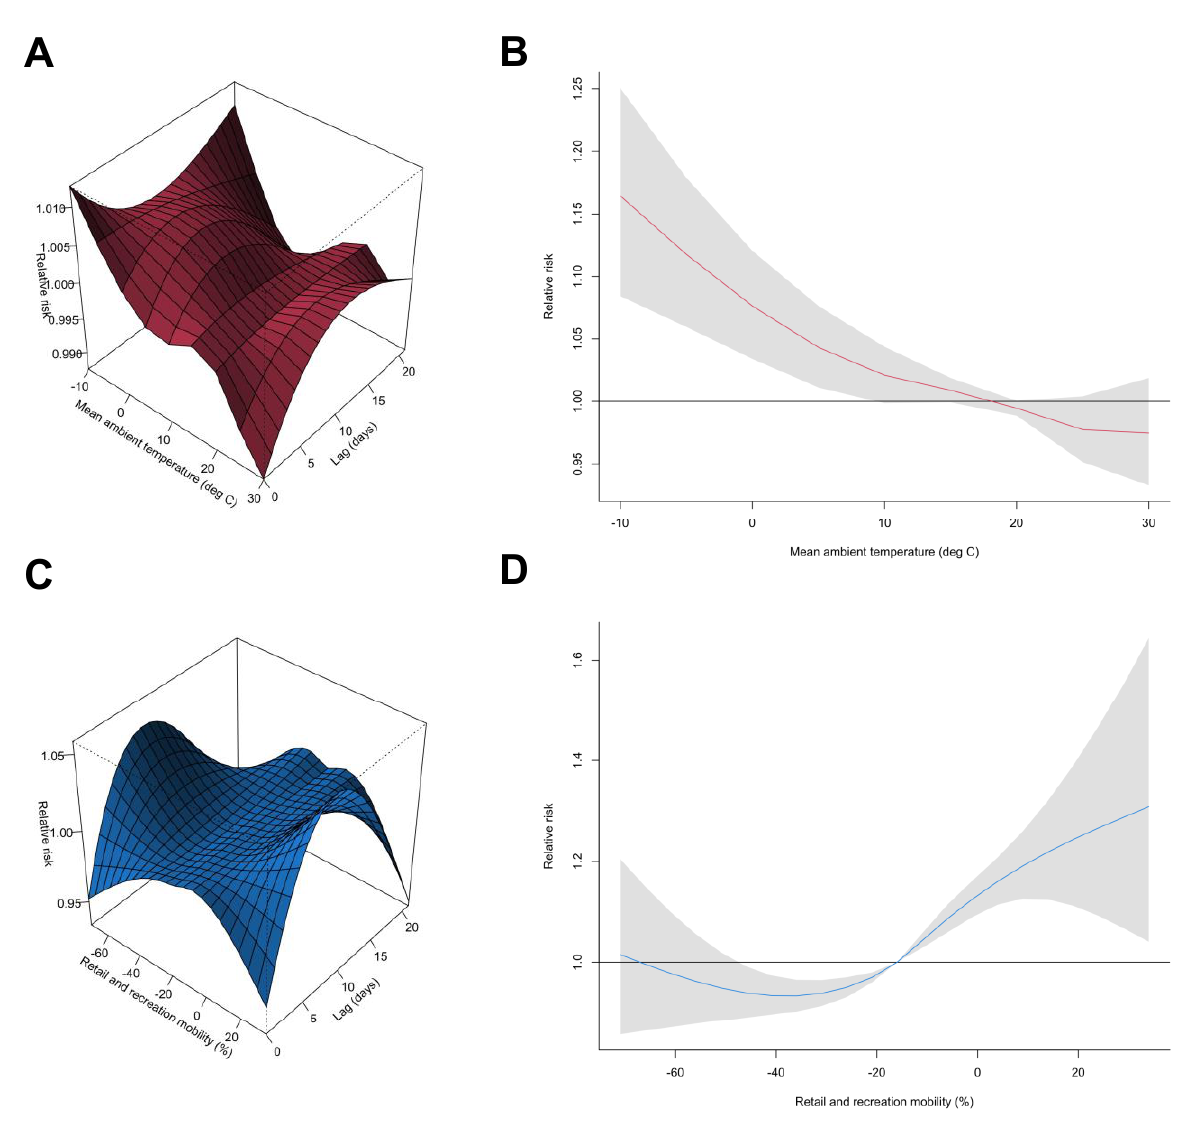
Figure 3. Visualizing pooled non-linear and delayed associations of the relative risks of time-dependent SARS-CoV-2 transmissibility with mean ambient temperature and retail and recreation mobility. ( A ) Three-dimensional plot of the association between daily mean ambient temperature (units: ◦ C) and the percent change in estimated time-dependent effective reproductive number ( R t ) over a lag of 21 days. ( B ) Overall associations of the 21-day cumulative risk of the percent change in the estimated time-dependent R t of SARS-CoV-2 with daily mean ambient temperature (units: ◦ C). ( C ) Three-dimensional plot of the association between daily retail and recreation mobility (units: %) and the percent change in estimated time-dependent R t over a lag of 21 days. ( D ) Overall asso- ciations of the 21-day cumulative risk of the percent change in estimated time-dependent R t of SARS-CoV-2 with daily retail and recreation mobility (units: %). Red and blue lines represent the estimated cumulative relative risks of time-dependent SARS-CoV-2 transmissibility, with shaded bands as 95% CIs. The corresponding reference levels were 18.5 ◦ C and − 16.0%, respectively.